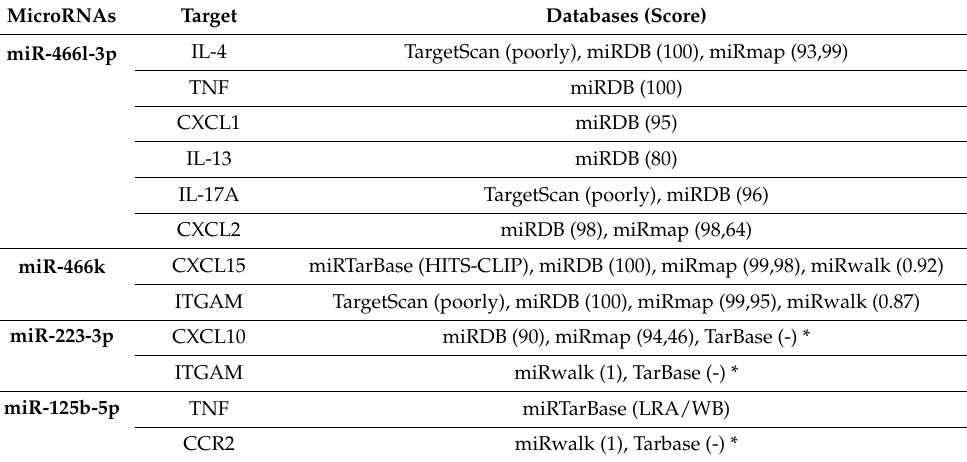
enzyme linked immunosorbent assays) or high throughput techniques (microarray or proteomics experiments) [23,27]. HITS-CLIP, high-throughput sequencing of RNAs isolated by